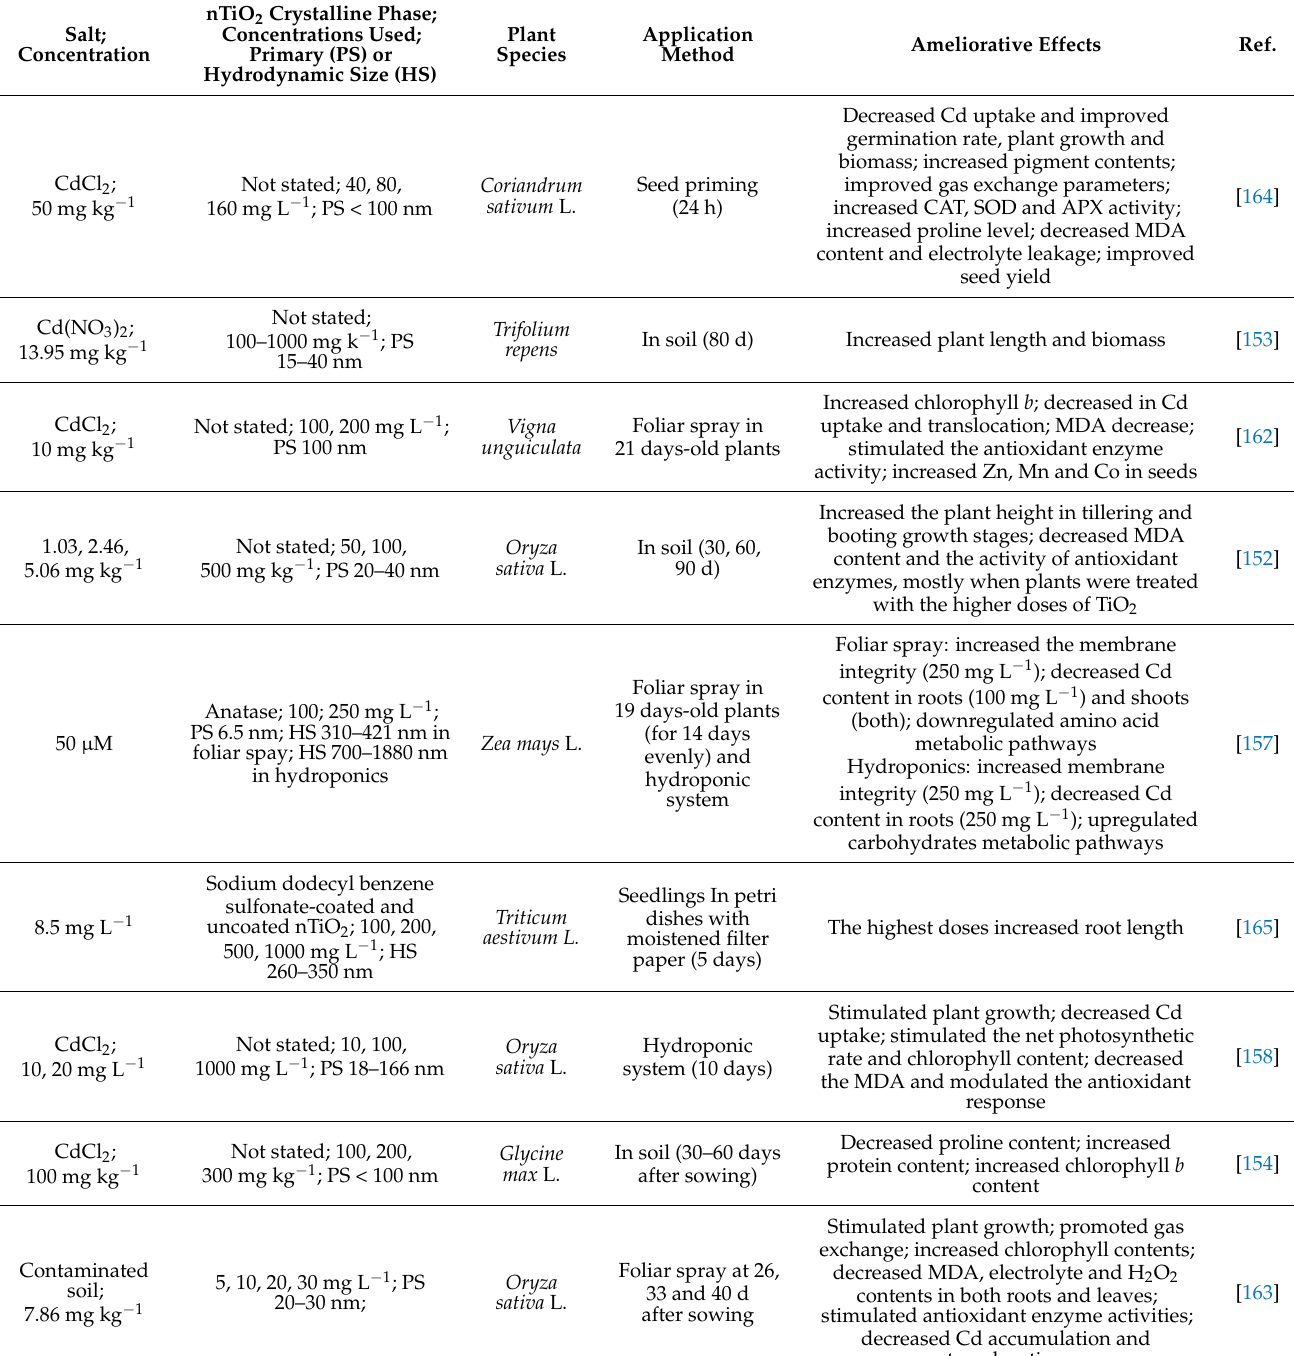
Table 5. Ameliorative effects of nTiO 2 application against the phytotoxicity of Cadmium